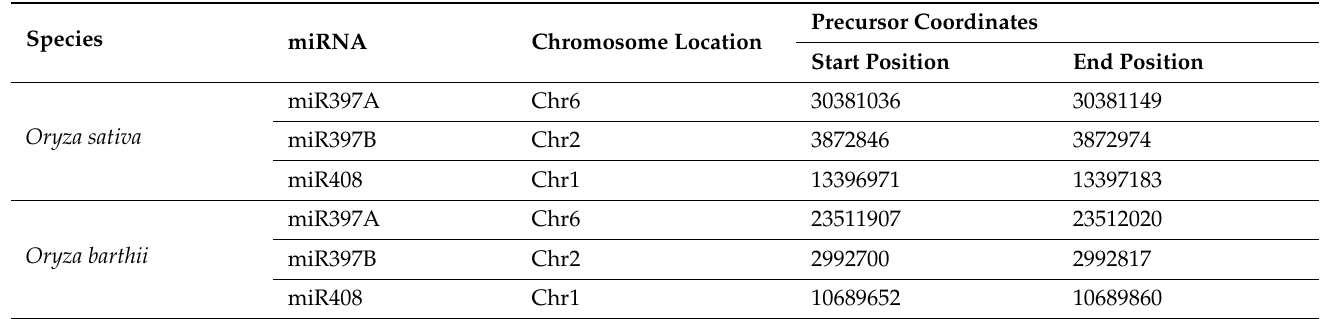
Figure 1. Genomic location of MIRNA homologs present on chromosomes of different poaceae members. Genomic location of ( A ) MIR397A , ( B ) MIR397B , and ( C ) MIR408 homologs present on chromosomes of different poaceae members. Pointed triangles mark the positions of respective MIRNAs on genus-specific chromosomes. Table 1. Chromosomal locations and coordinates of each miRNA homolog in grass